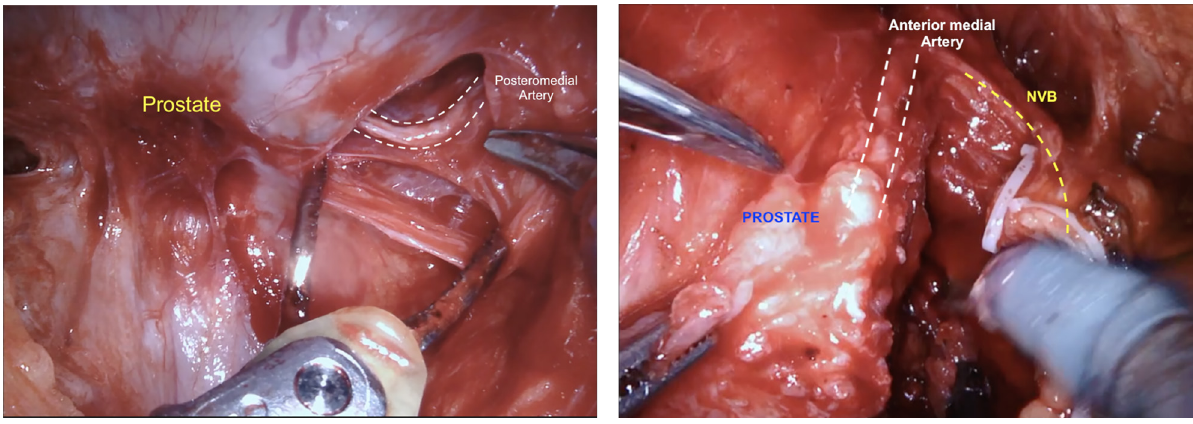
Figure 8 - Posterior view under the prostate illustrating the posterior medial